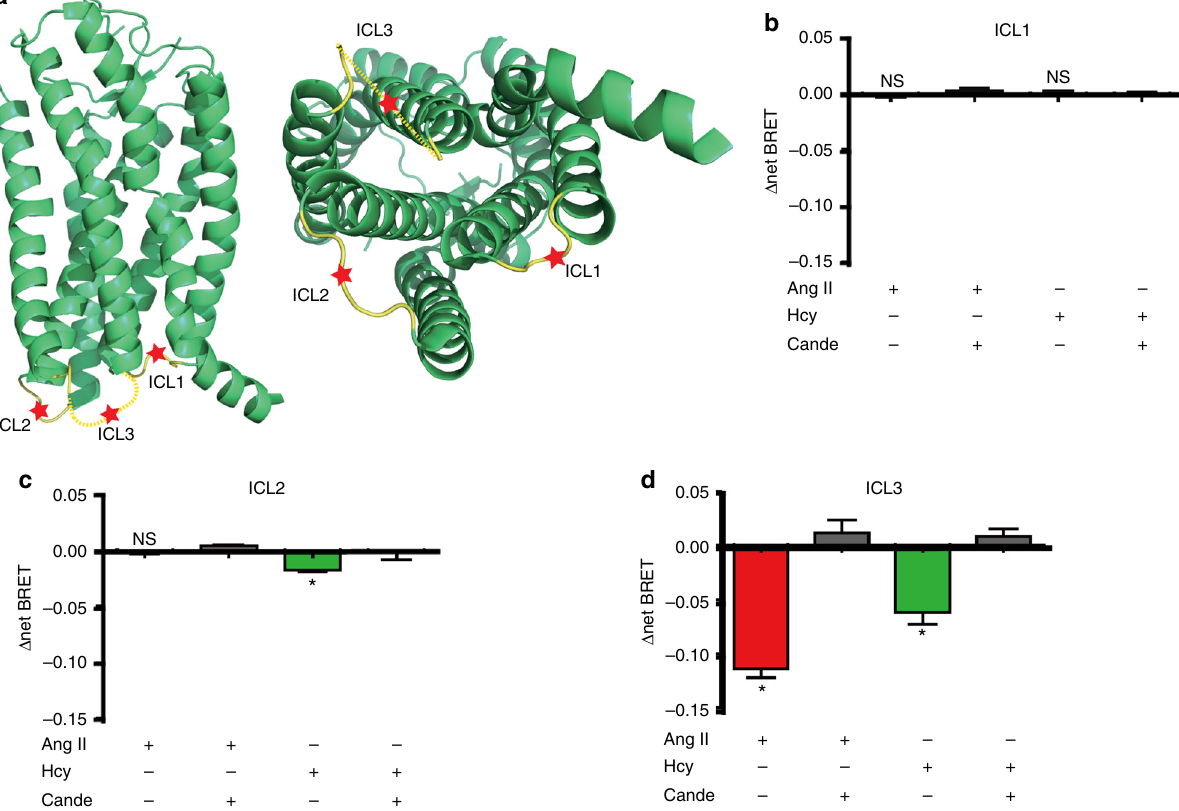
Fig. 4 Hcy and Ang II induce different conformational changes of the AT1 receptor. a Schematic diagram of AT1 receptor-ICL-FlAsH-Rluc constructs. b – d Intramolecular Δ net BRET measured in HEK293A cells (transfected separately with the three constructs ICL1 – 3) stimulated by Ang II (1 μ M) or Hcy (100 μ M) with or without candesartan (0.1 μ M) pretreatment. The data represent as mean ± SEM, N = 6, * P < 0.05, one-way ANOVA followed by the Bonferroni post hoc test. ICL, intracellular